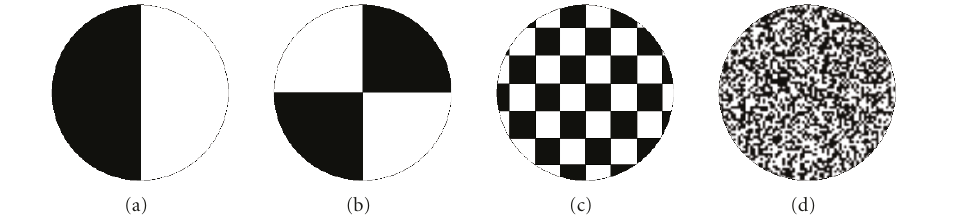
Figure 2: Regions of di ff erent complexity with the same gray-level entropy.